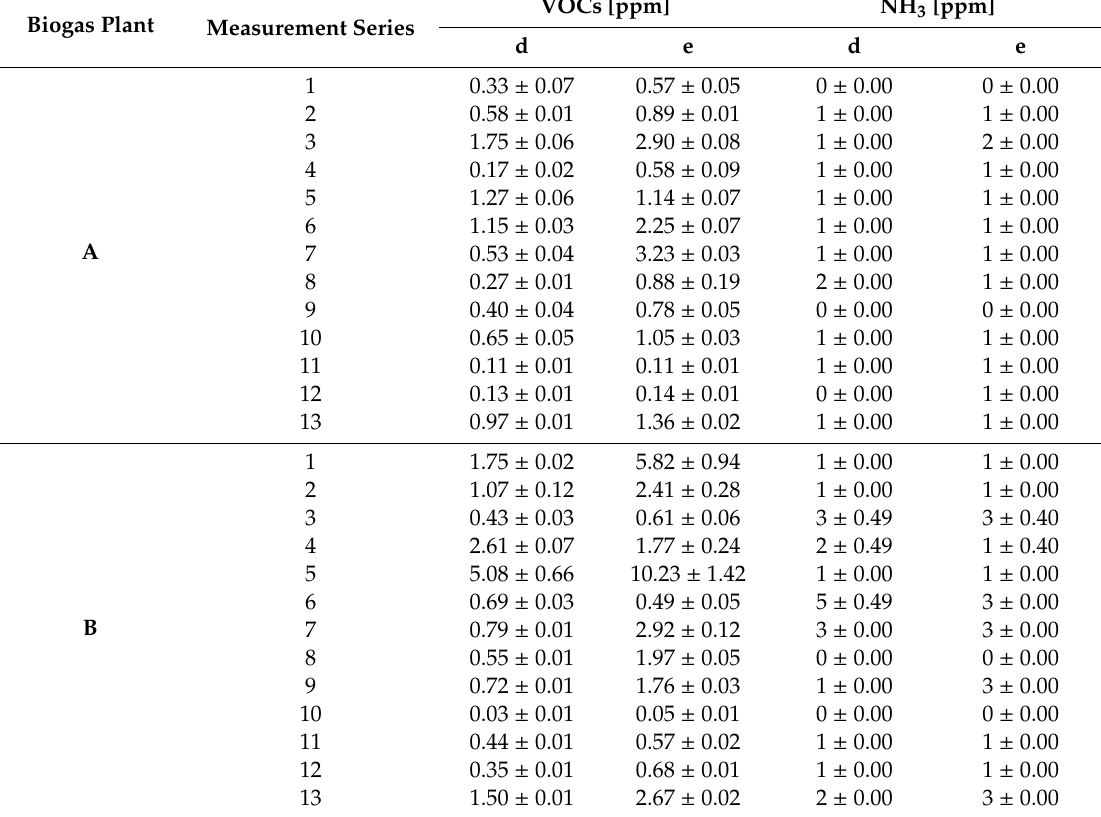
Table 4. Measurement results for the mechanical treatment